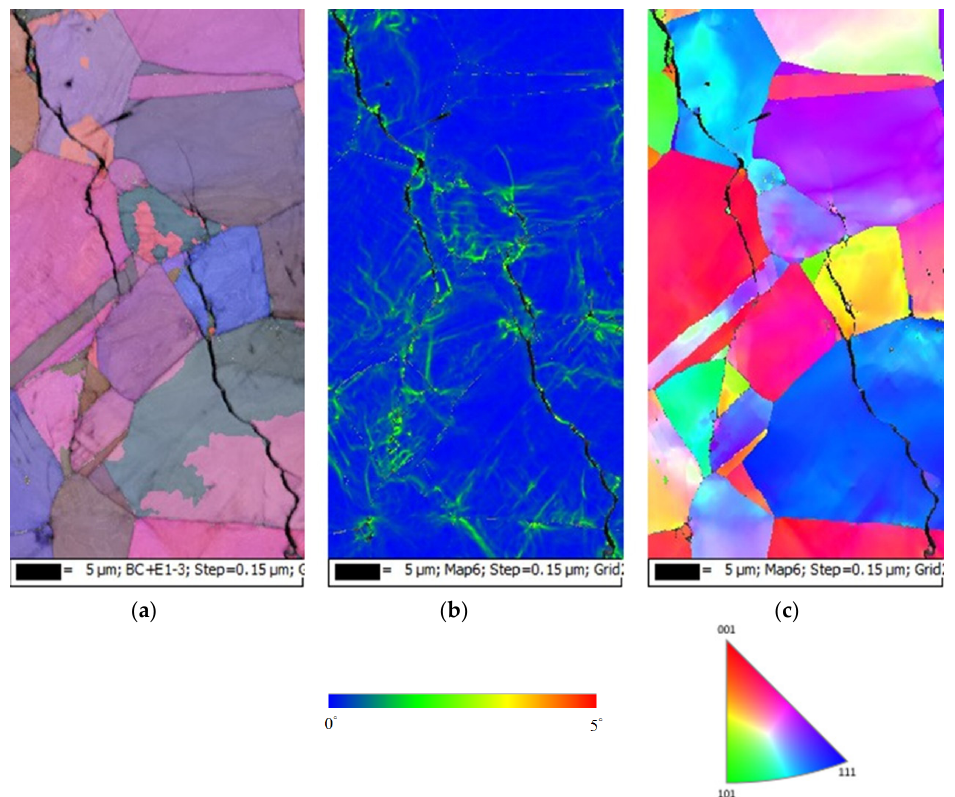
Figure 9. Electron back scatter di ff raction (EBSD) maps for the crack region after 5000 h tests with 1 g / m 2 chloride concentration and relative humidity of 55%. ( a ) Euler map, ( b ) kernel average misorientation (KAM) map, and ( c ) inverse pole figure (IPF) map.